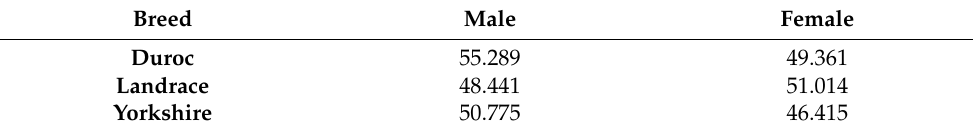
Table A1. Constant correction coefficients for AGE of pig breeds.